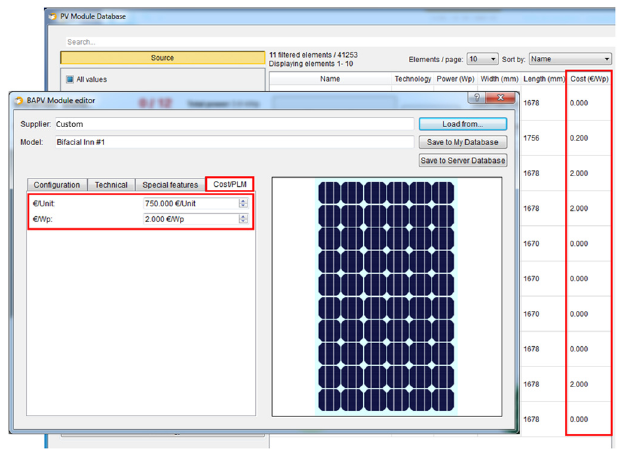
Fig. 4. Improved database of